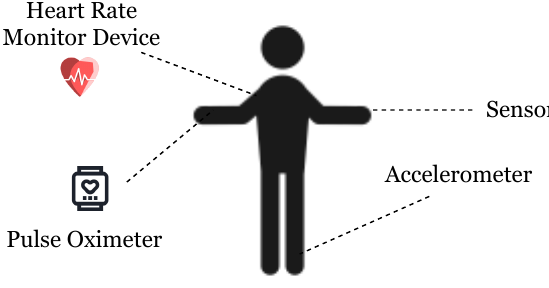
Figure 3. Wearable devices for the patient.